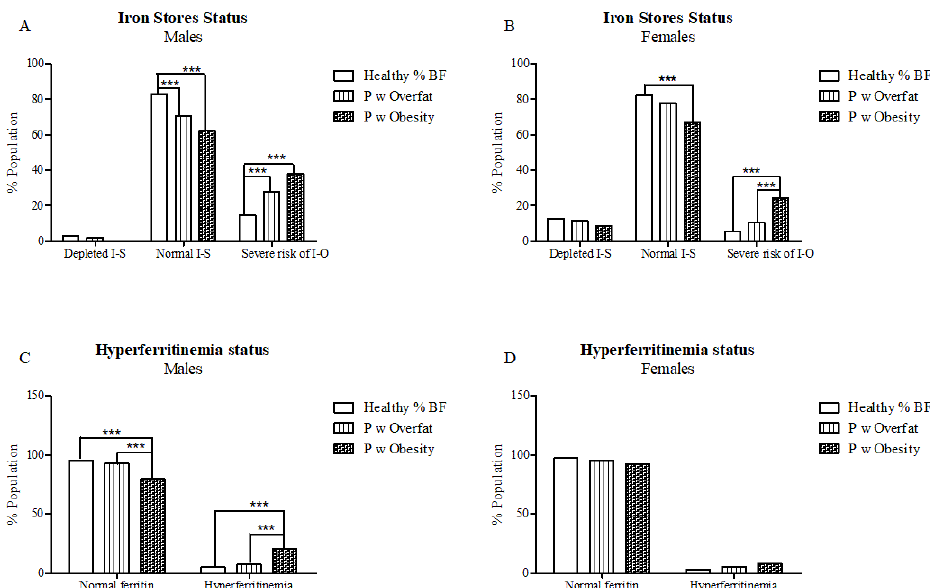
Figure 1. The relationship between % body fat category and ( A , B ) WHO iron status category as determined by ferritin and ( C , D ) HEIRS ferritin status. *** p < 0.001 (Bonferroni correction). X 2 test of categorical variables, with data presented as % study population. % BF = percentage body fat. P w overfat/obesity = people with overfat/obesity, I-S = iron stores, and I-O = iron